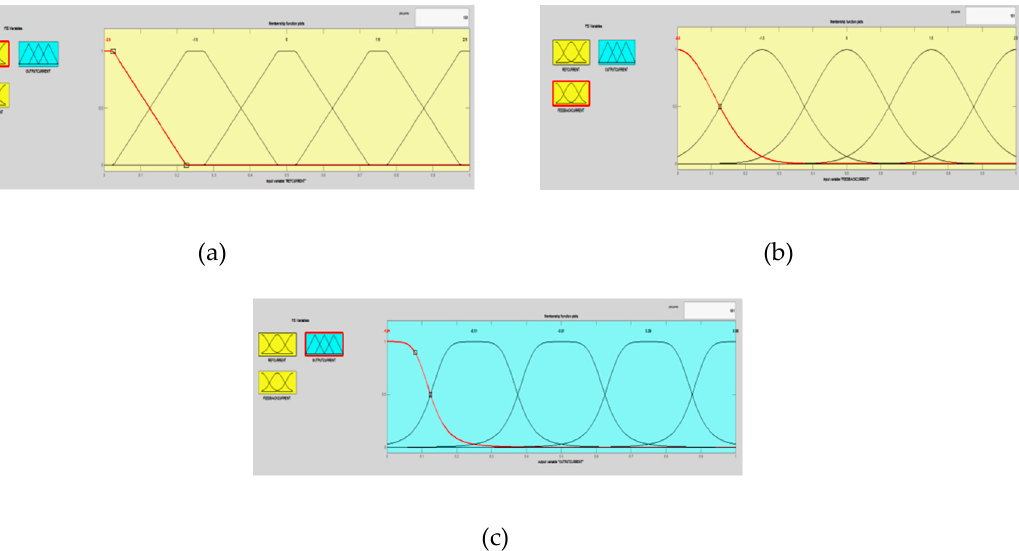
Figure 23. Membership Functions for Rule 4: ( a ) Input 1(error); ( b ) Input 2 (change in error); ( c ) output. The overall rule viewer plot is shown in Figure 24.